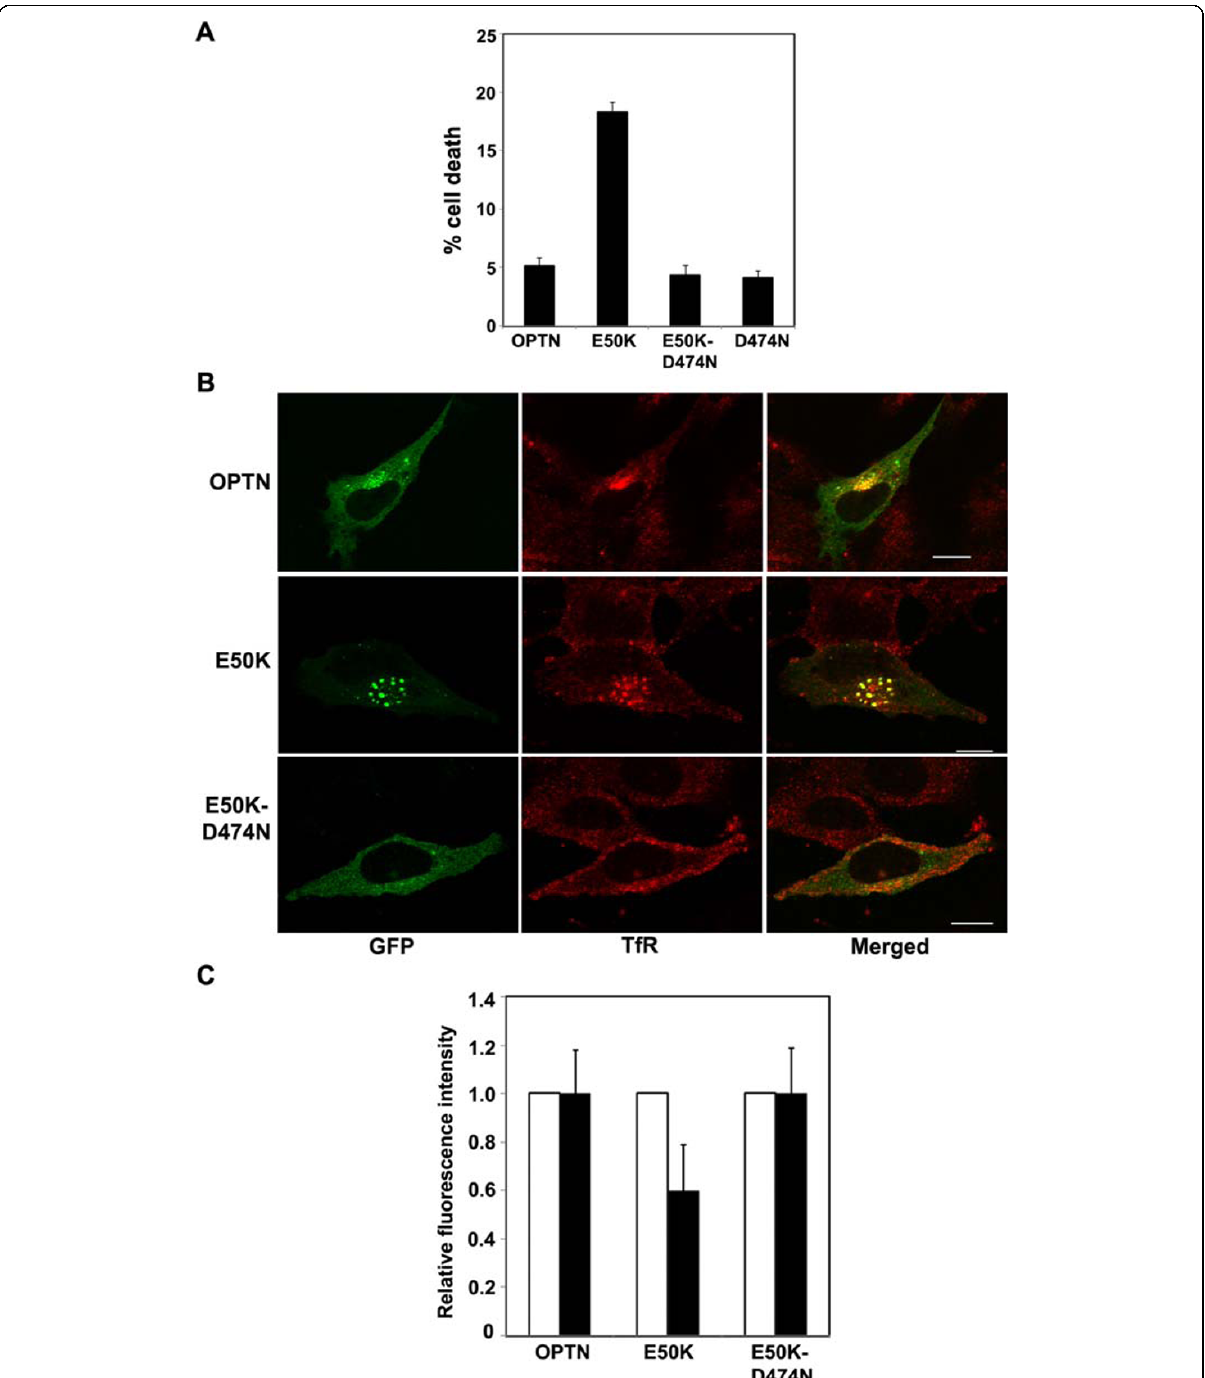
Figure 12 The induction of cell death in RGC-5 cells by E50K mutant requires the UBD . (A) RGC-5 cells were transfected with wild type optineurin or E50K mutant or their UBD mutants and percentage of cells undergoing cell death were quantified in transfected and untransfected cells. Data represent mean ± SD of 3 independent experiments. (B) E50K mutant colocalizes with TfR in RGC5 cells. GFP-tagged optineurin or its mutants were transfected in RGC-5 cells and stained for TfR. E50K mutant optineurin forms large vesicular structures that co- localize strongly with TfR indicated by yellow colour in the merged image. (C). E50K mutant causes reduced uptake of transferrin in RGC-5 cells. RGC-5 cells were transfected with GFP- tagged wildtype optineurin or its mutants and incubated with Alexa-546 conjugated transferrin for 20 min. Cells were then fixed and observed with a confocal microscope. The uptake of labelled transferrin was quantitated by measuring the fluorescence intensity in expressing (filled bar) and non-expressing (empty bar) cells. Bar; 10 μ